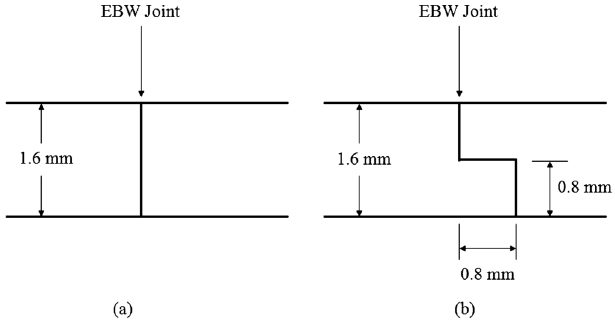
FIG. 1. Cross section of (a) butt joint design and (b) typical step joint